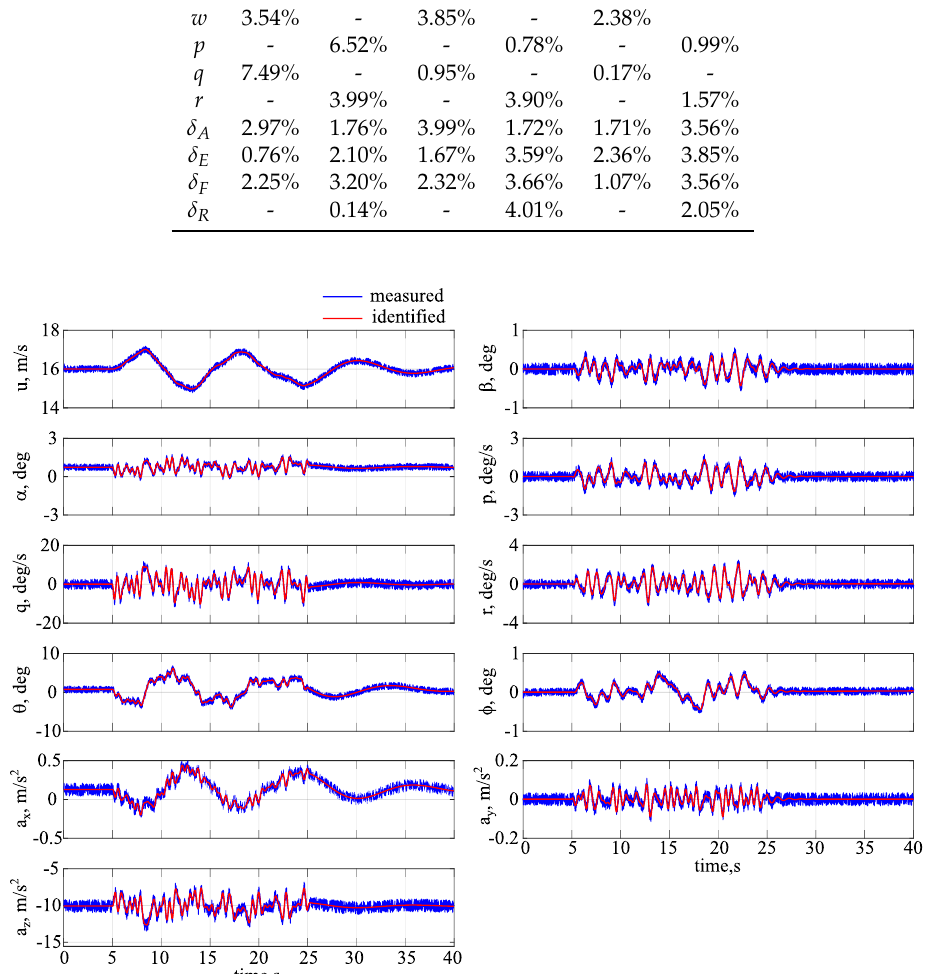
Figure 10. Time histories for the multisine elevator